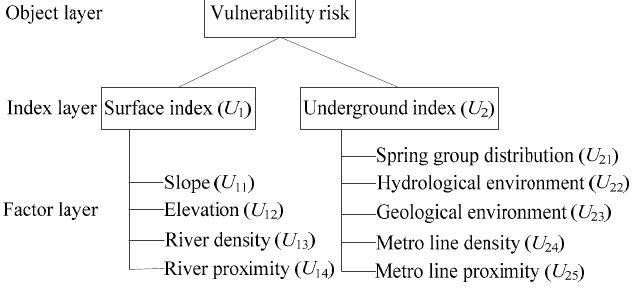
Figure 9. Structure of assessment index system.